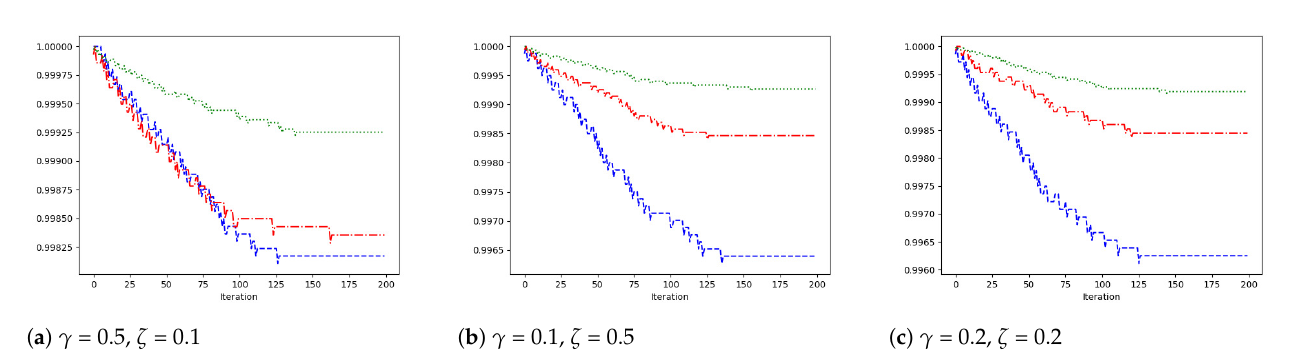
Figure 7. Convergence behaviour of average user utility (2) for multiple user populations (small (blue), medium (red), large